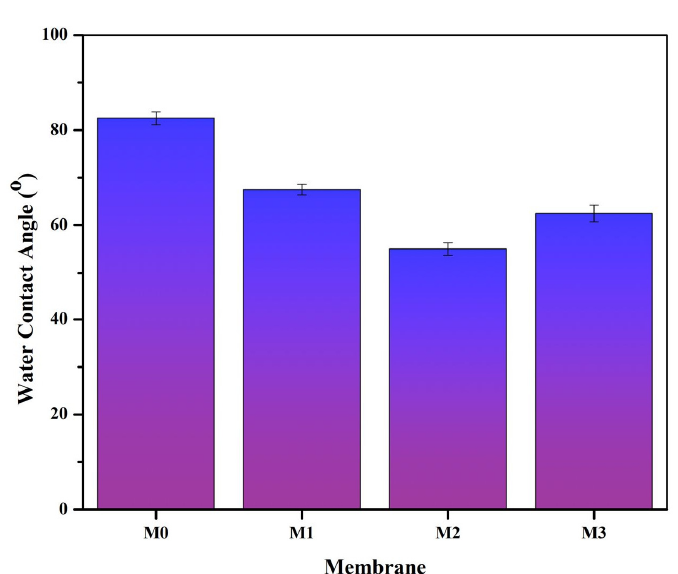
Figure 6. Water Contact Angle (WCA) values on M0 (pure PVDF membrane), M1 (PVDF + Pol), M2 (PVDF + Pol + S-CnT), and M3 (PVDF + Pol + M-CnT). The measurement of the water contact angle was carried out on the dried sample by dropping 0.7 µL of water on the top surface of the membrane. The original PVDF membrane (M0) has a very high water contact angle value (82.5